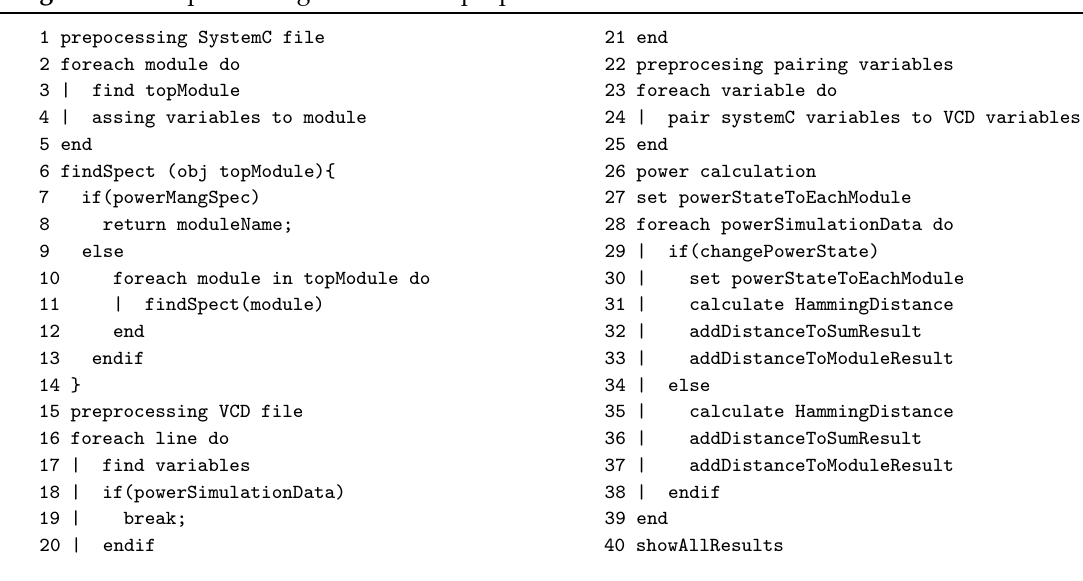
Algorithm 1: A pseudo-algorithm of the proposed